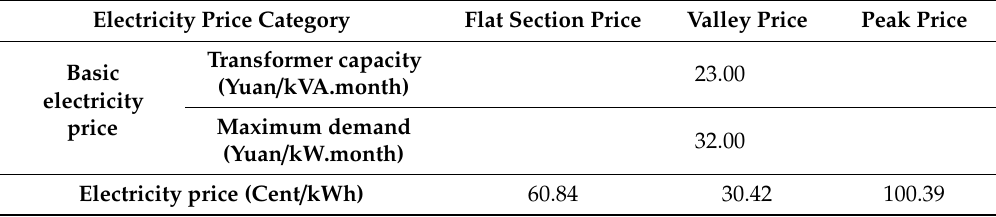
Table 2. Step price list in a certain area of Guangdong.